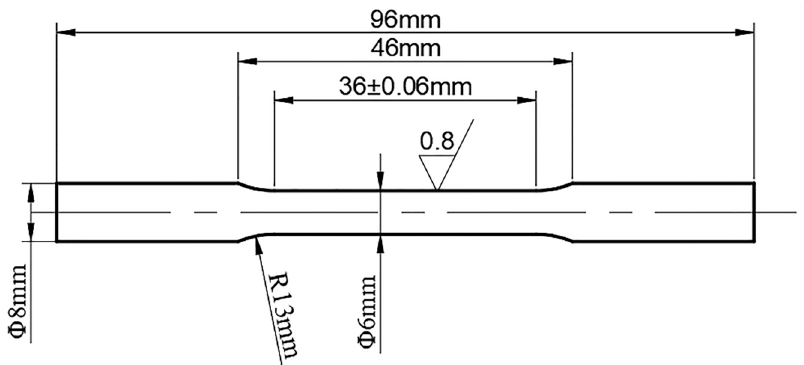
Figure 1. Tensile specimen.